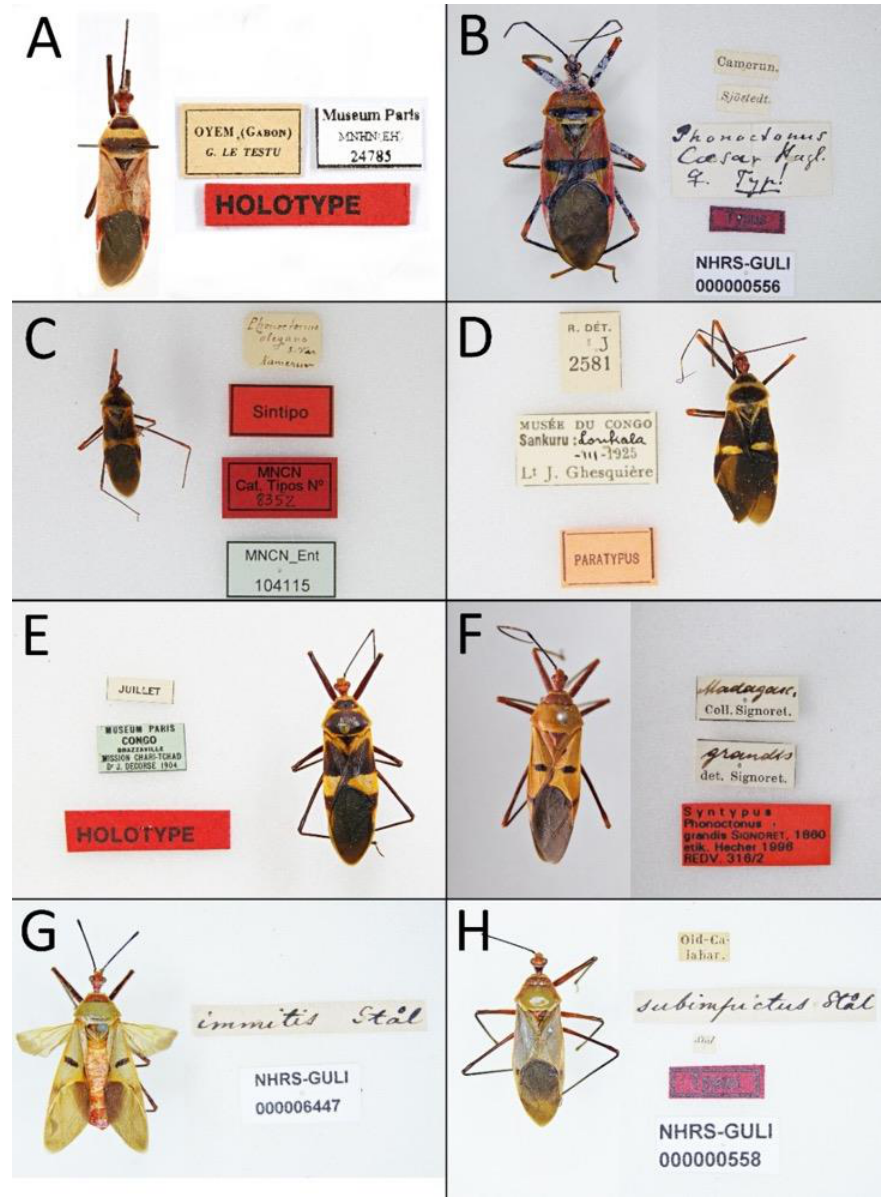
Figure 31. Type specimens of the representatives of Phonoctonus Stål, 1853: ( A ) Phonoctonus bifasciatus Villiers, 1948; ( B ) P. caesar Haglund, 1895; ( C ) P. elegans Varela, 1904; ( D ) P. elegans var. stricta Schouteden, 1932; ( E ) P. fairmairei Villiers, 1948; ( F ) P. grandis Signoret, 1860; ( G ) P. immitis Stål, 1865; and ( H ) P. subimpictus Stål, 1865.